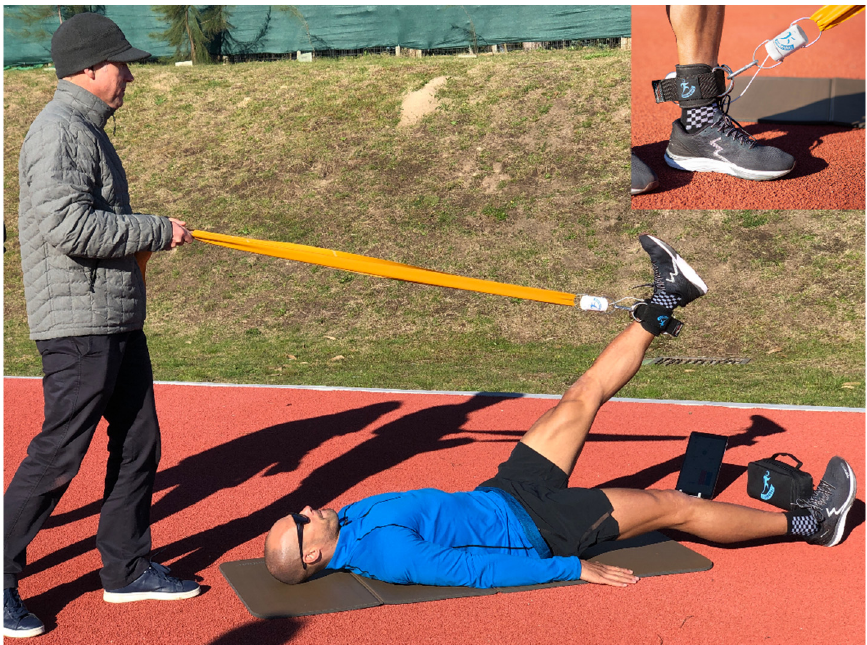
Figure 1. DINABANG in use during sport training supervision. Note the lightweight device tied to the elastic band. During this hip extension hamstring muscles as well as agonists are active.